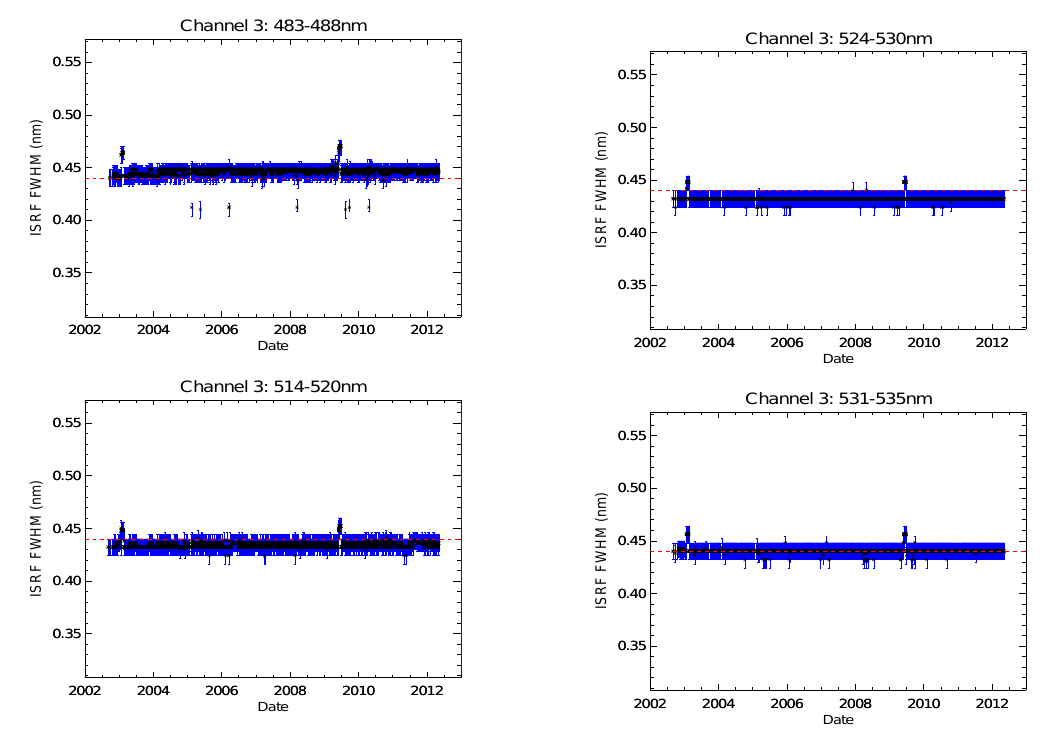
Figure 13. Similar to Figure 11 but for Channel 3. The four plots correspond to the four spectral lines from Table